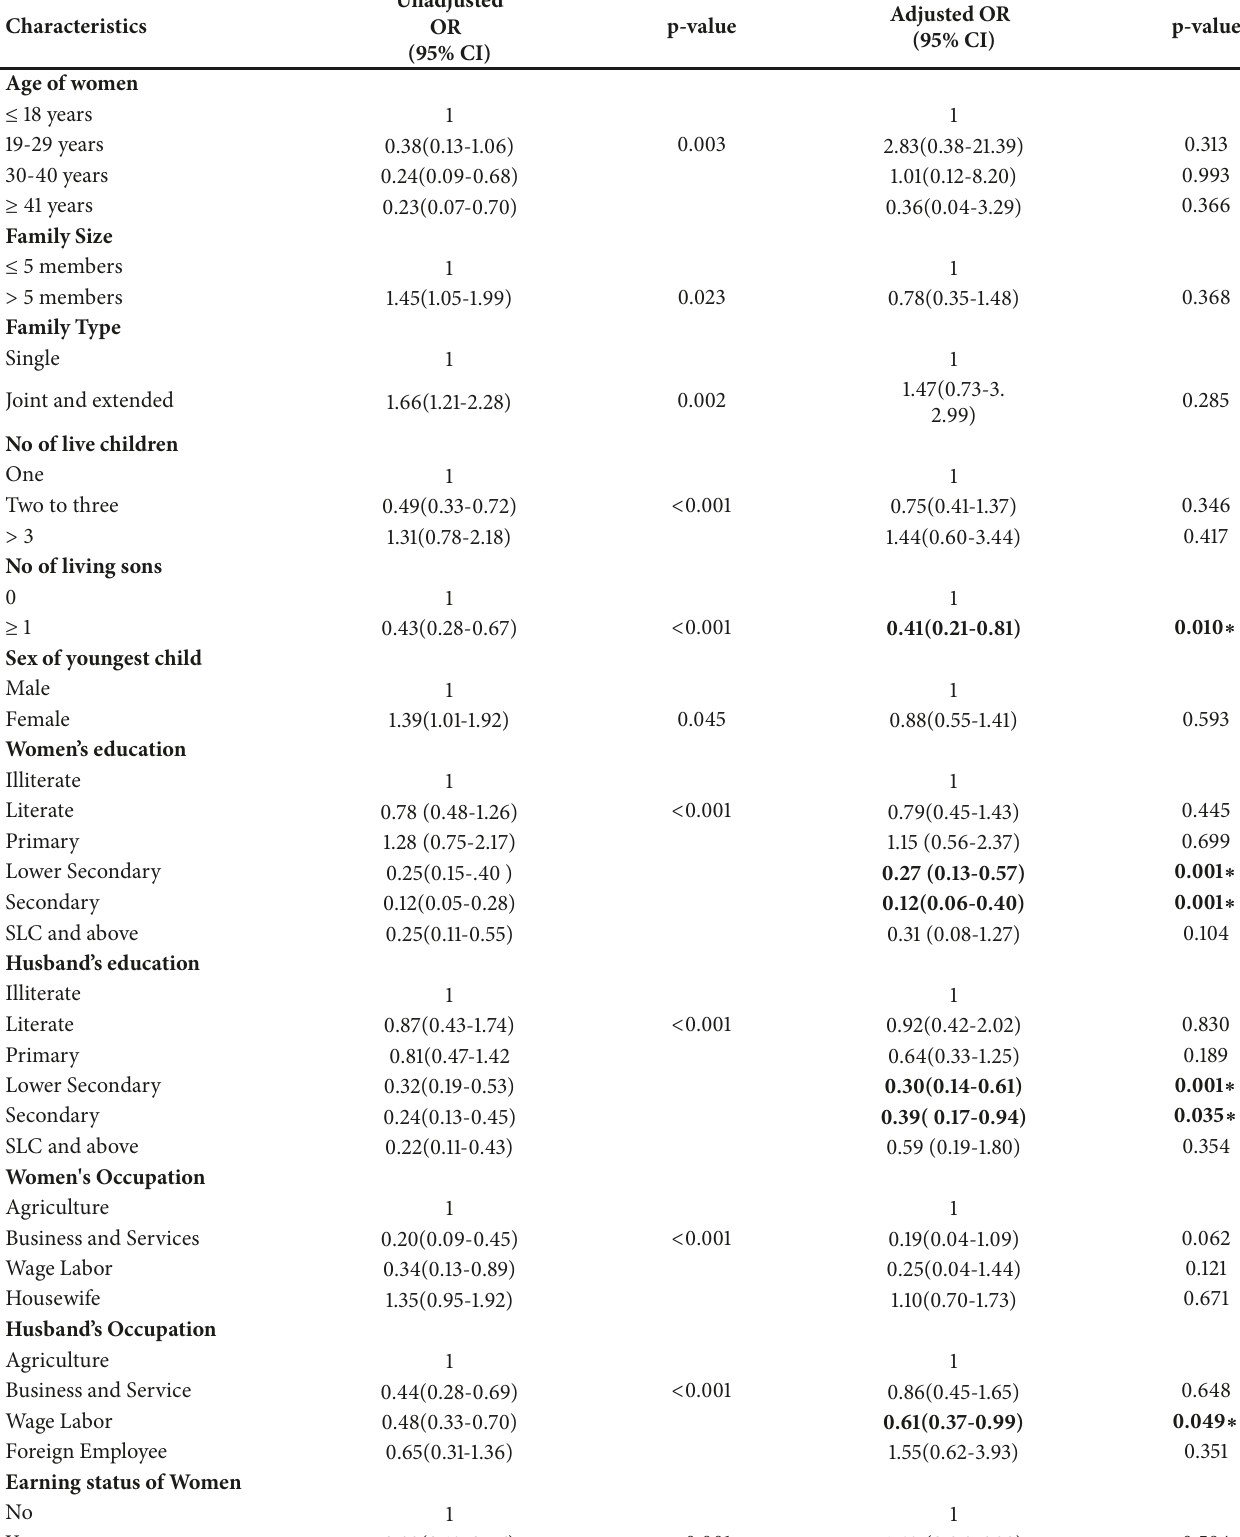
Table 4: Factors affecting unmet need for family planning in using bivariate and multivariate